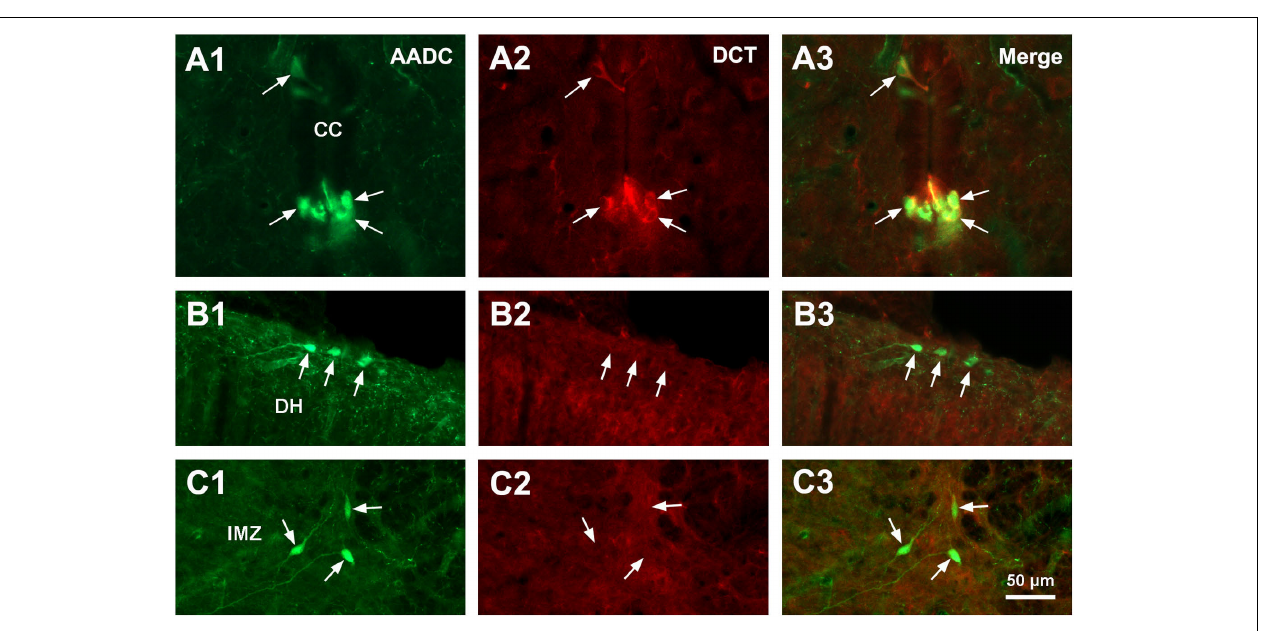
FIGURE 3 | Aromatic L -amino acid decarboxylase and doublecortin (DCT) double-immunostaining indicates that AADC cells in different parts of the spinal gray matter are in different states of maturity. (A1–C3) AADC neurons around the CC were immunopositive for DCT (A1–A3) , whereas in the DH (B1–B3) and the IMZ (C1–C3) they were DCT-immunonegative (arrows). All images were from transverse sections at sacral segments. AADC antibody was from sheep. Scale bar in (C3) , valid for all panels, 50 µ